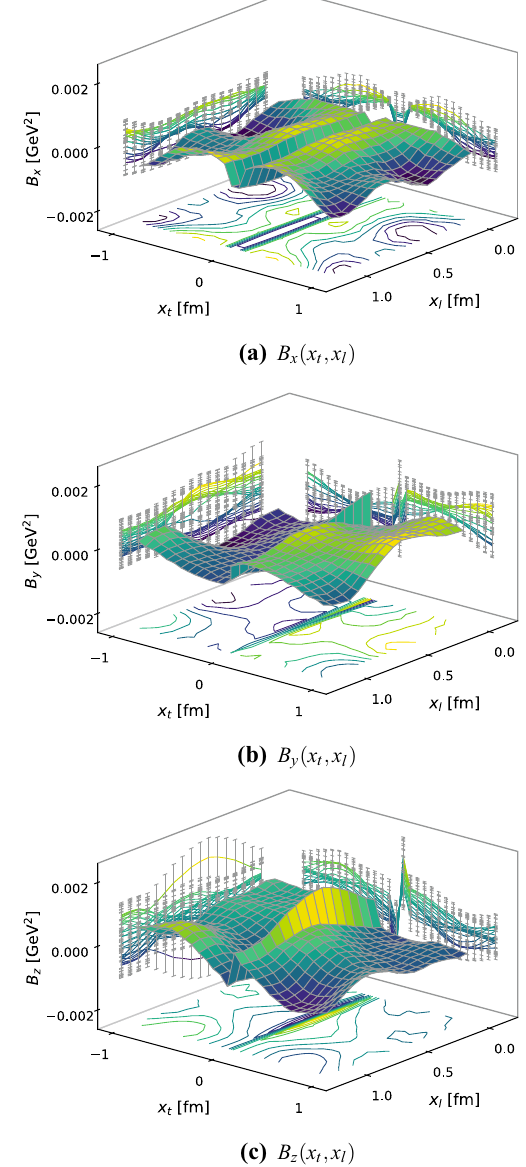
Fig. 3 Surface and contour plots for the three components of the chro- momagneticfieldat β = 6 . 240and d = 1 . 142fm.Allplottedquantities are in physical units